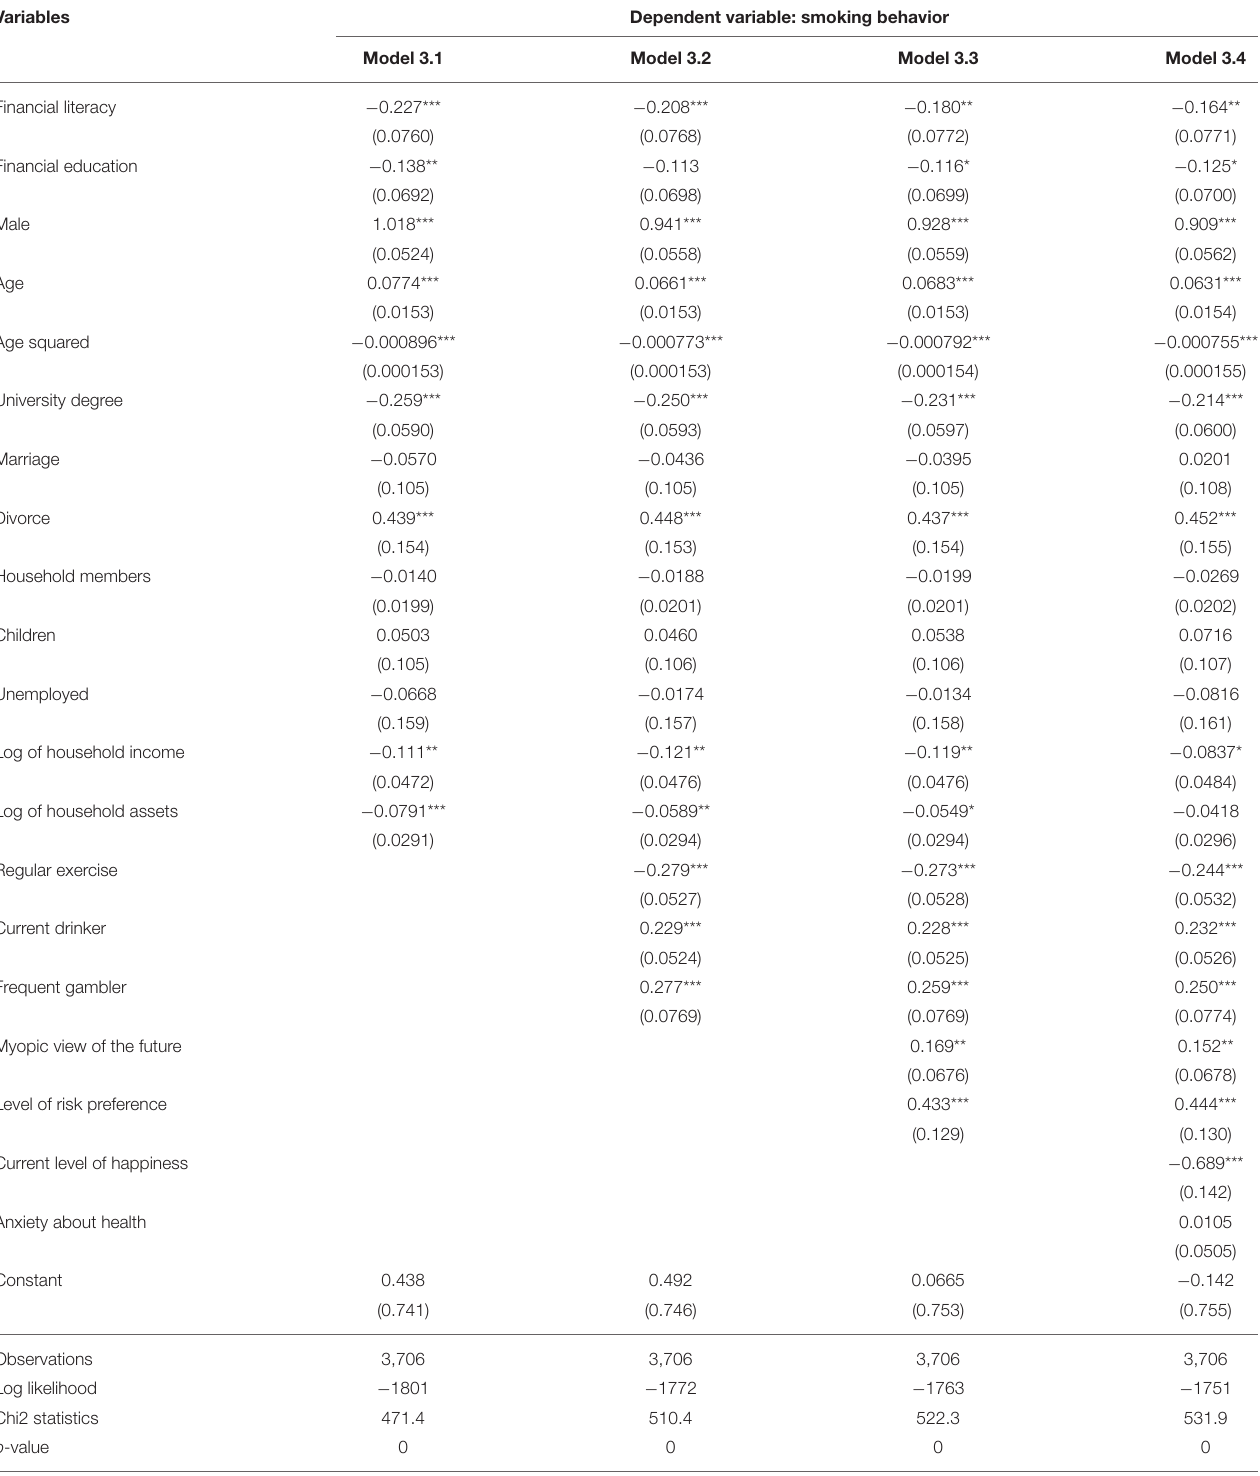
TABLE 8 | Probit model regression results, financial literacy, and financial education as the main explanatory